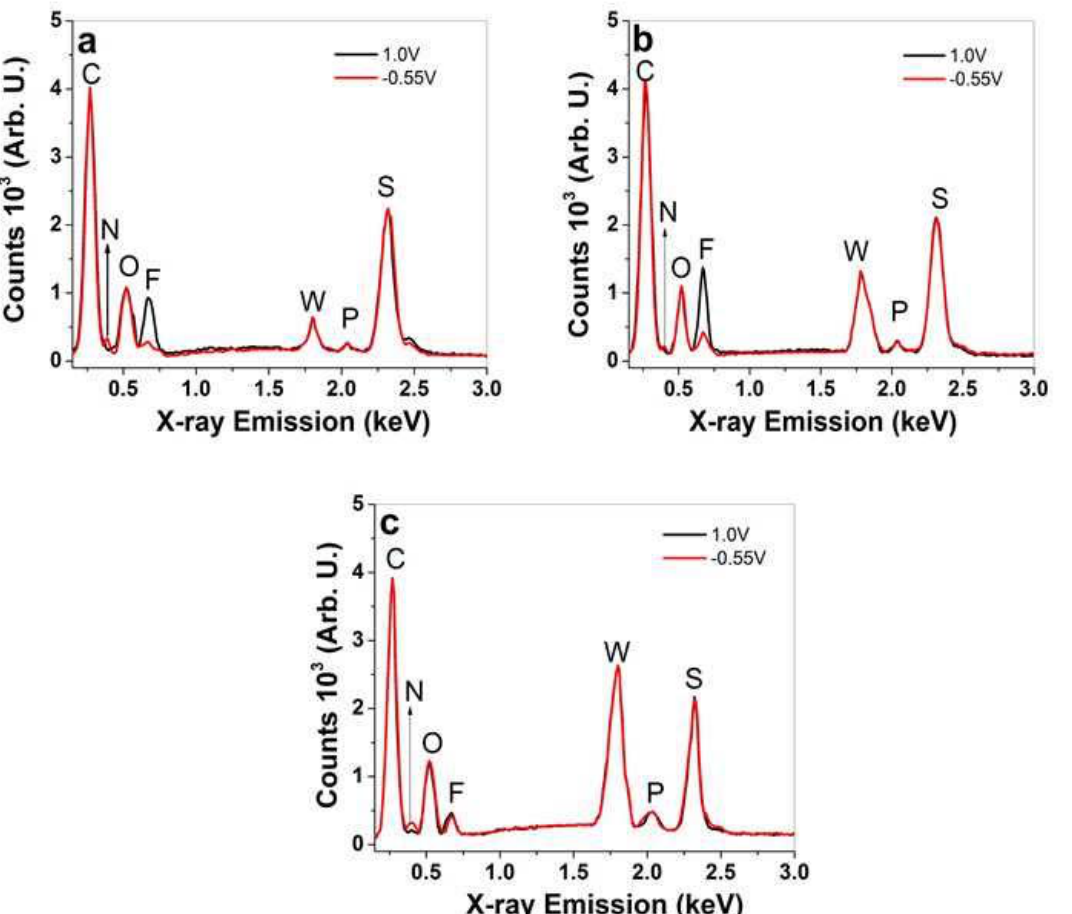
Figure 3a–c. The content of PPy/DBS-PT films directly after polymerization (oxidized state, ~1.0 V) is shown in Figure S2.